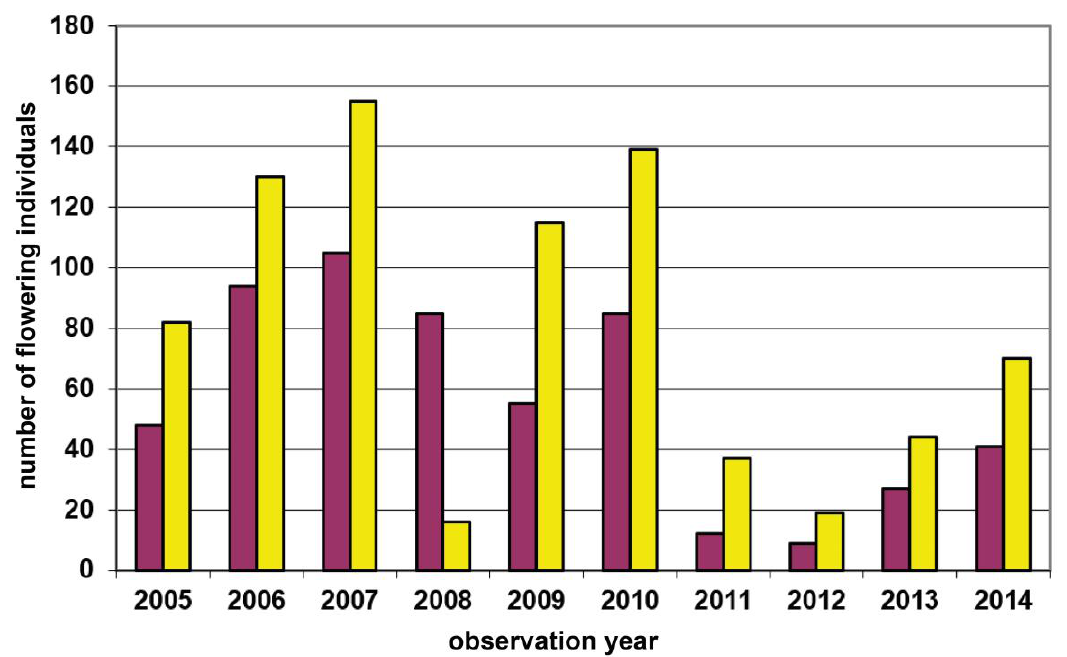
Figure A2. Population census (2005–2014) of the Dactylorhiza sambucina -population Münichreith in the Waldviertel region. Red columns = red-flowering plants and yellow columns = yellow-flowering plants.